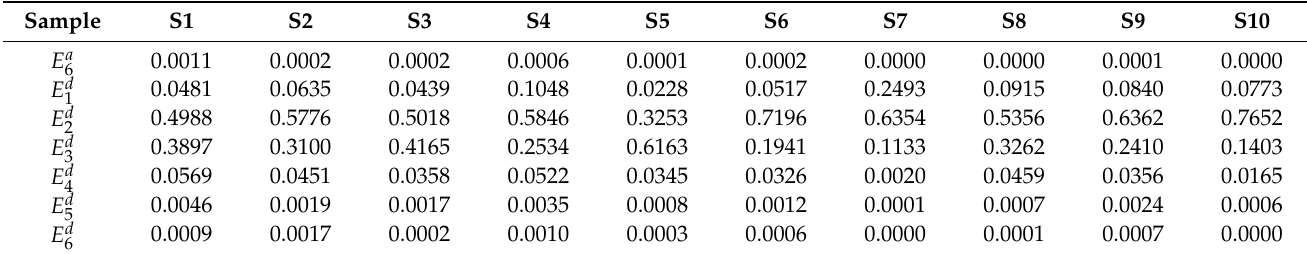
Table 1. Energy eigenvector of moving gravel particle acoustic